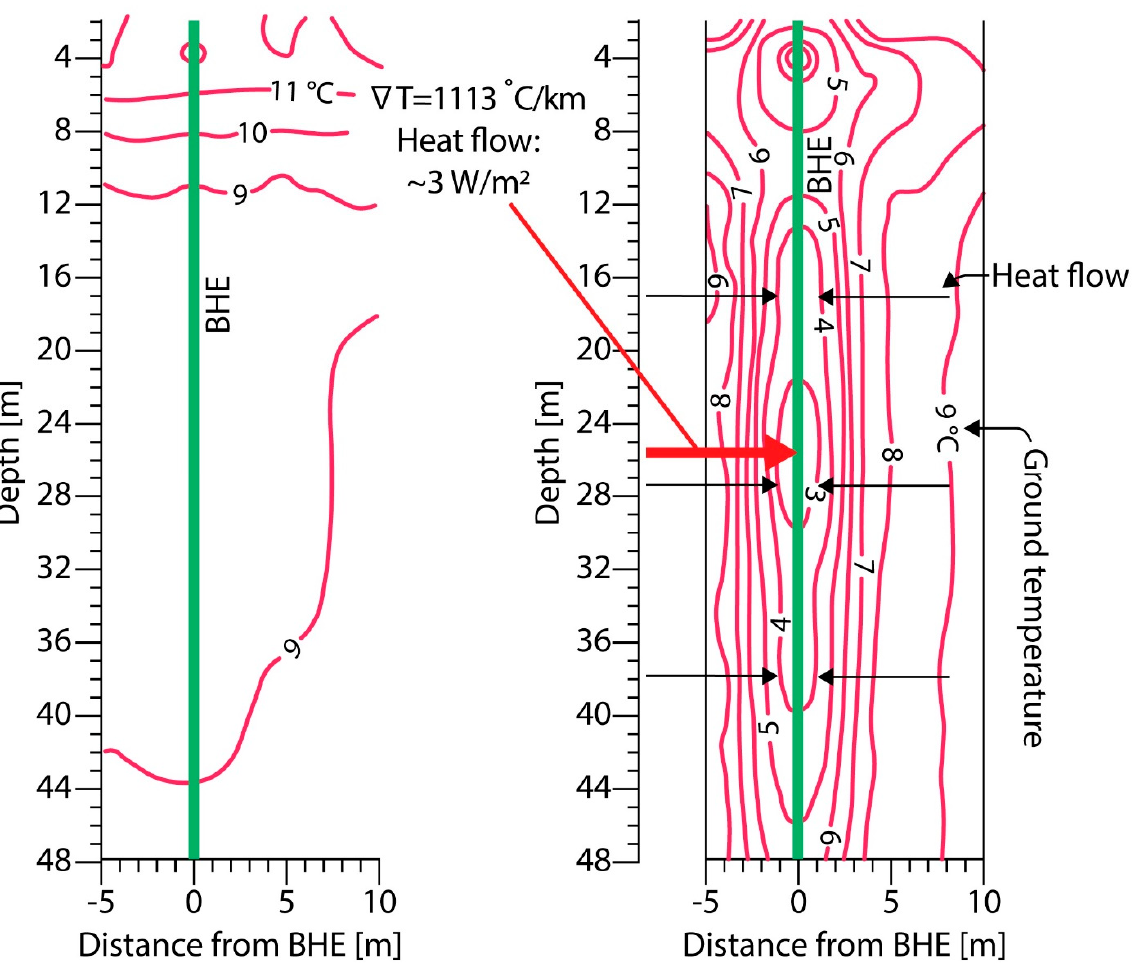
Figure 13. Measured temperature distribution in the ground at the beginning of the monitoring period ( left , on 1.10.1986, after a total of ca. 2 h of test operation) and at the end of the first heating season ( right , on 1.5.1987), at GHP test plant, Schwalbach, Germany. The narrow, cylindrical isotherm pattern represents strong heat inflow. The red arrow shows the maximum. Data from [12] are plotted. For details, see text.